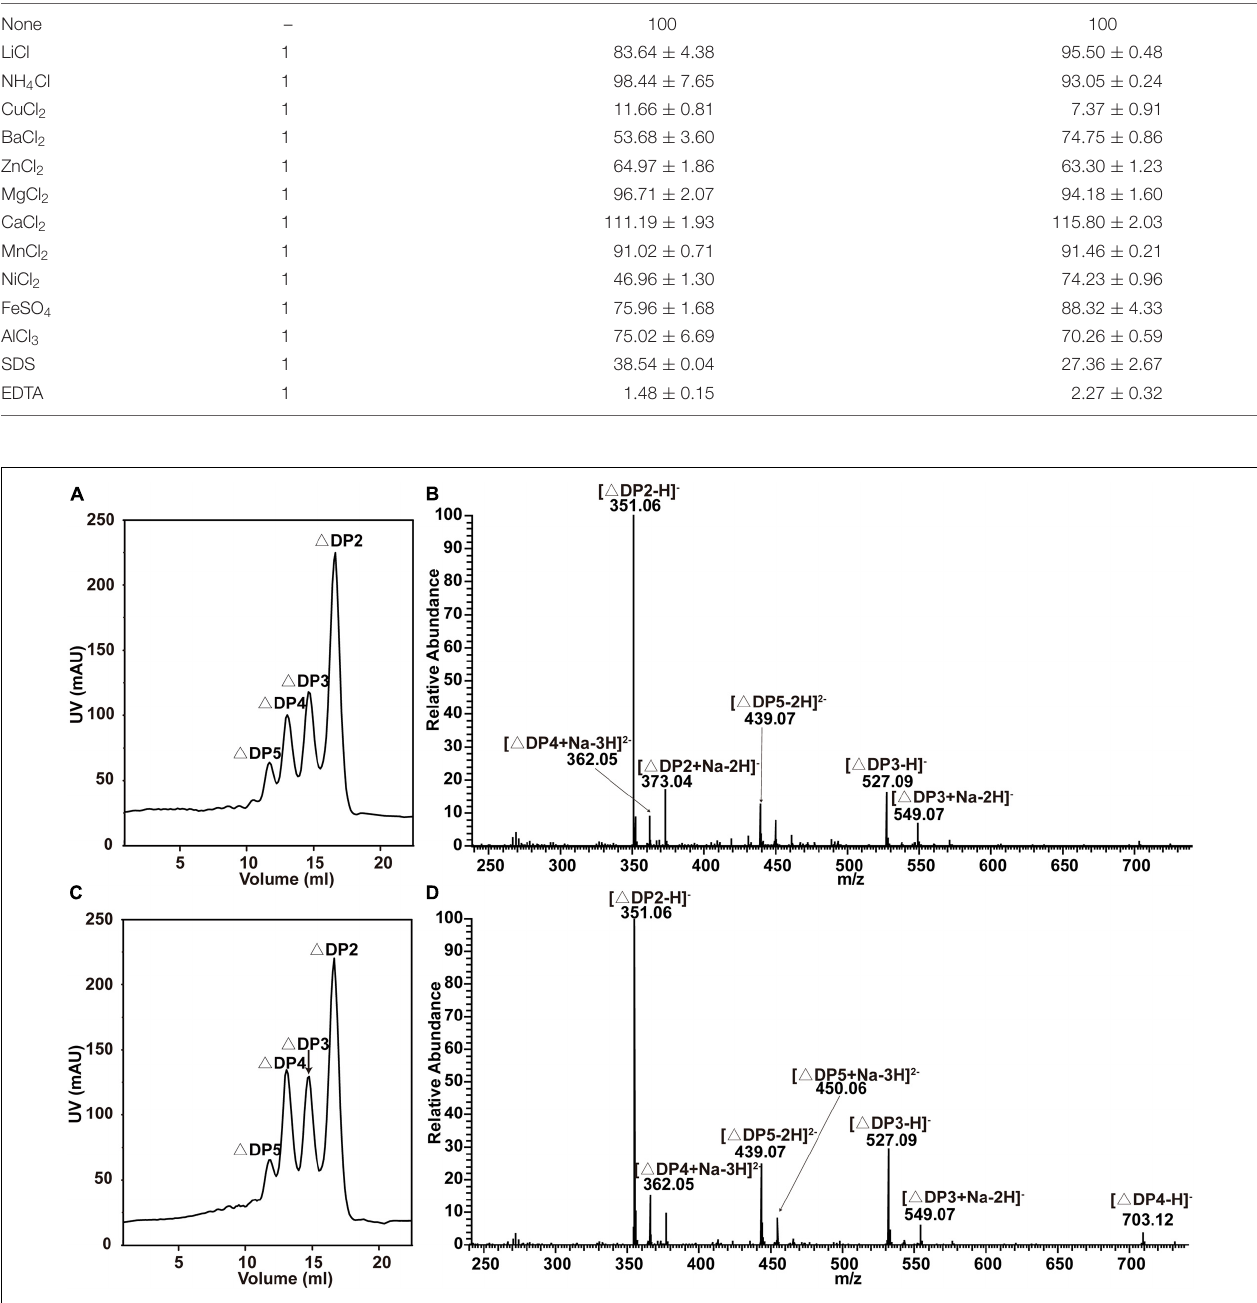
sugar content of the recombinant VxAly7B-FL system and the VxAly7B-CM system gradually increased, but the changes were more significant in the recombinant VxAly7B-FL system